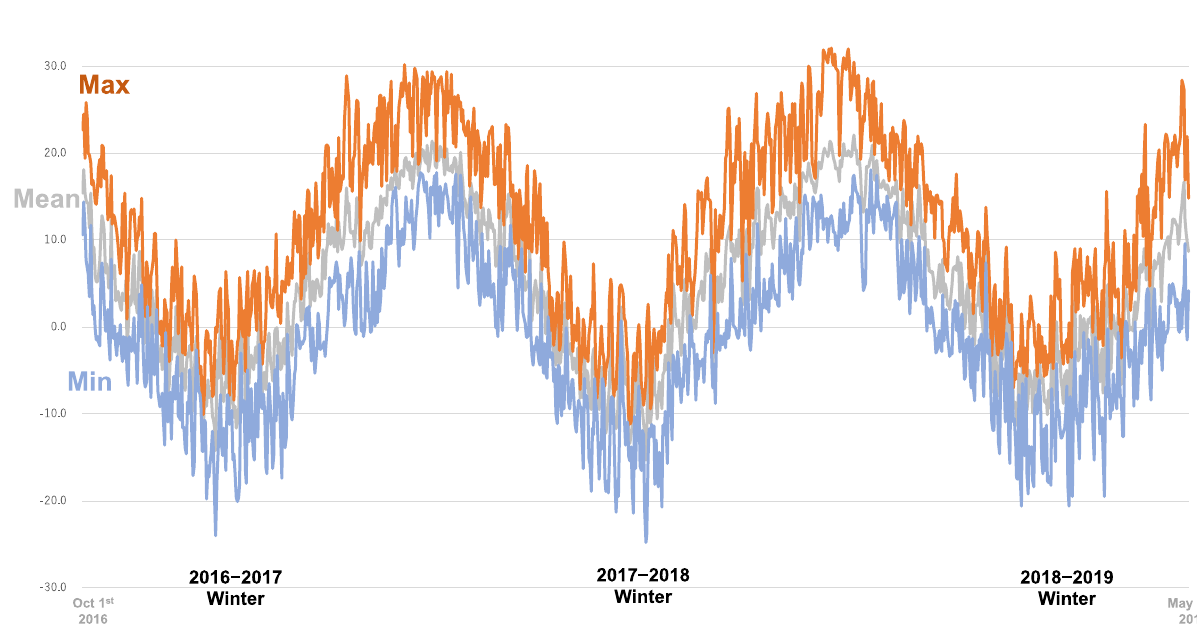
Figure 1. Winter air temperature at the Kamikochi study site during the period 2017 to